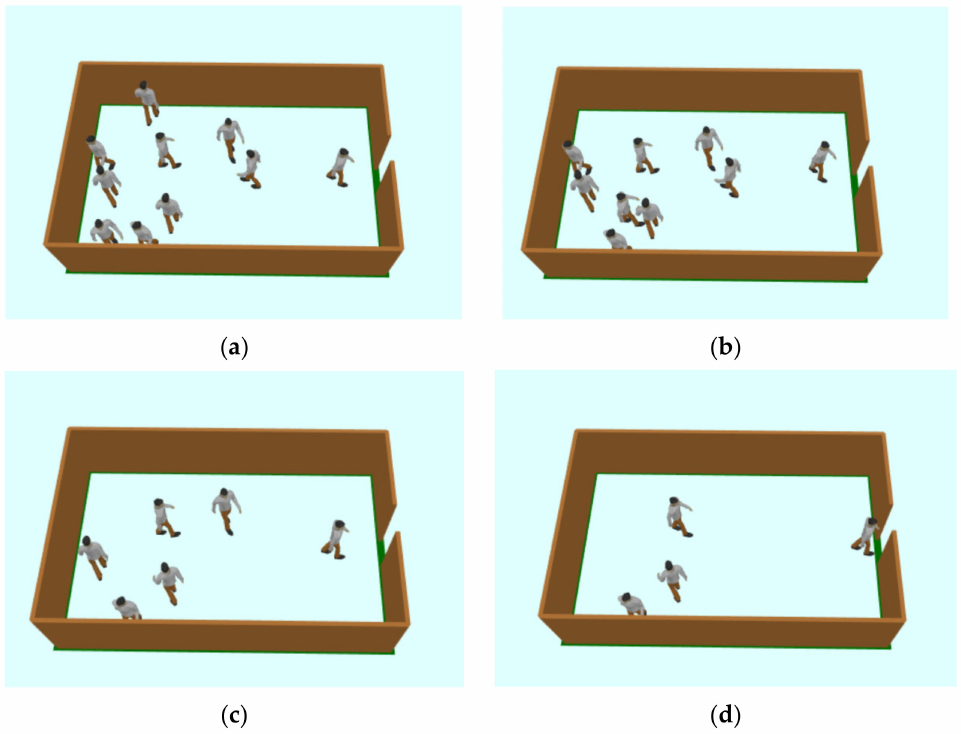
Figure A5. The scenario of test 5. ( a ) Time = 10 s; ( b ) time = 20 s; ( c ) time = 50 s; ( d ) time = 70 s. Test 6: Rounding corners.